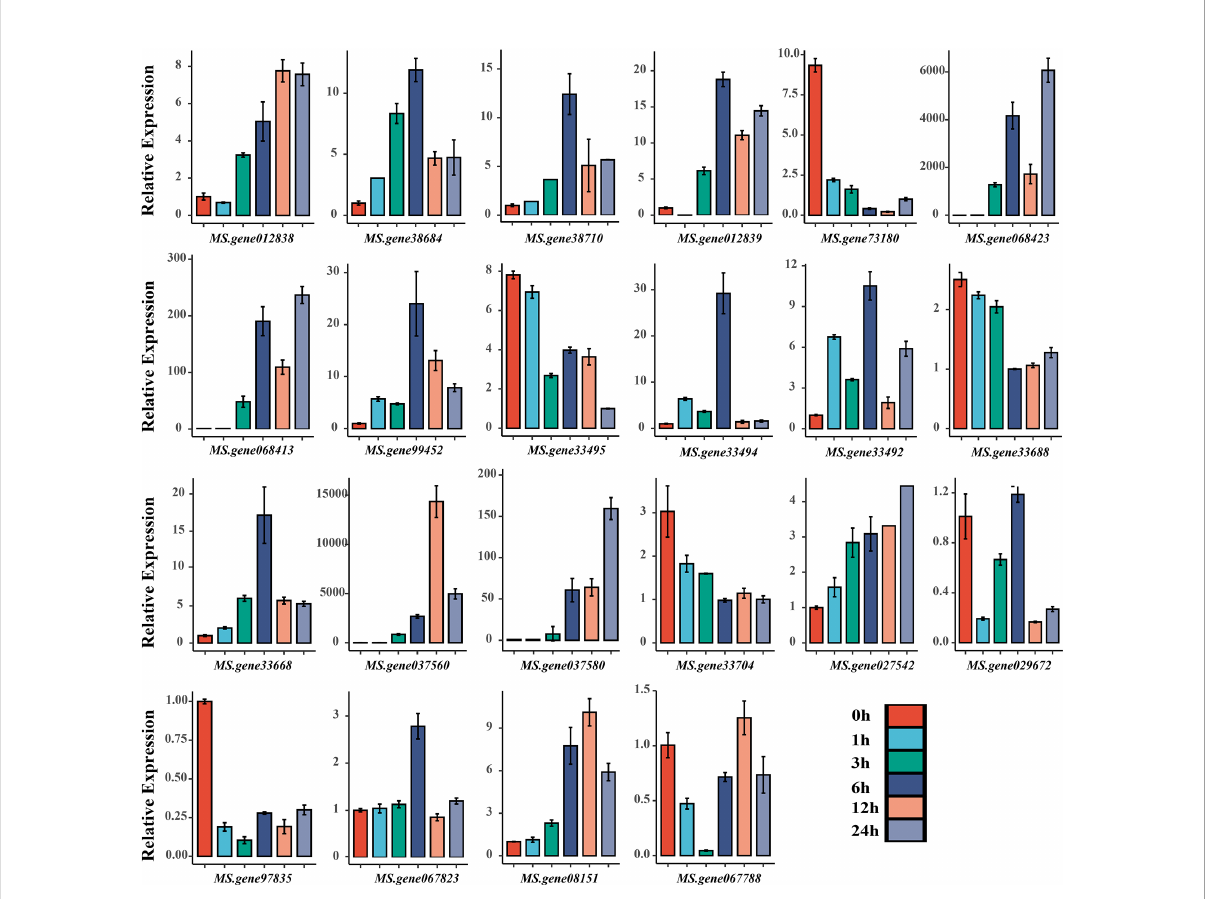
FIGURE 5 qRT-PCR analysis of the 22 candidate genes under drought